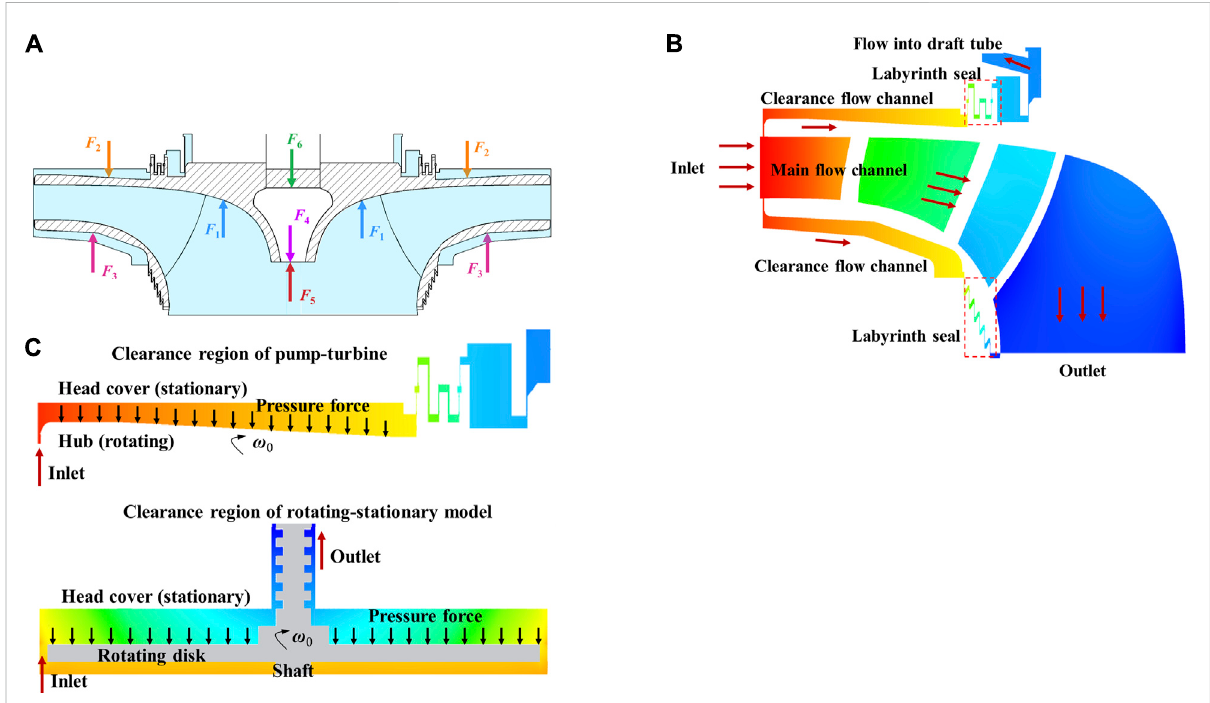
FIGURE 5 Pressureandaxialhydraulicthrustintheclearancecavity. (A) Schematicofaxialforcesofthepumpturbine. (B) Clearancepressuredistributions of the pump turbine. (C) Axial hydraulic thrust in the clearance cavity of the pumpturbine and rotating – stationary